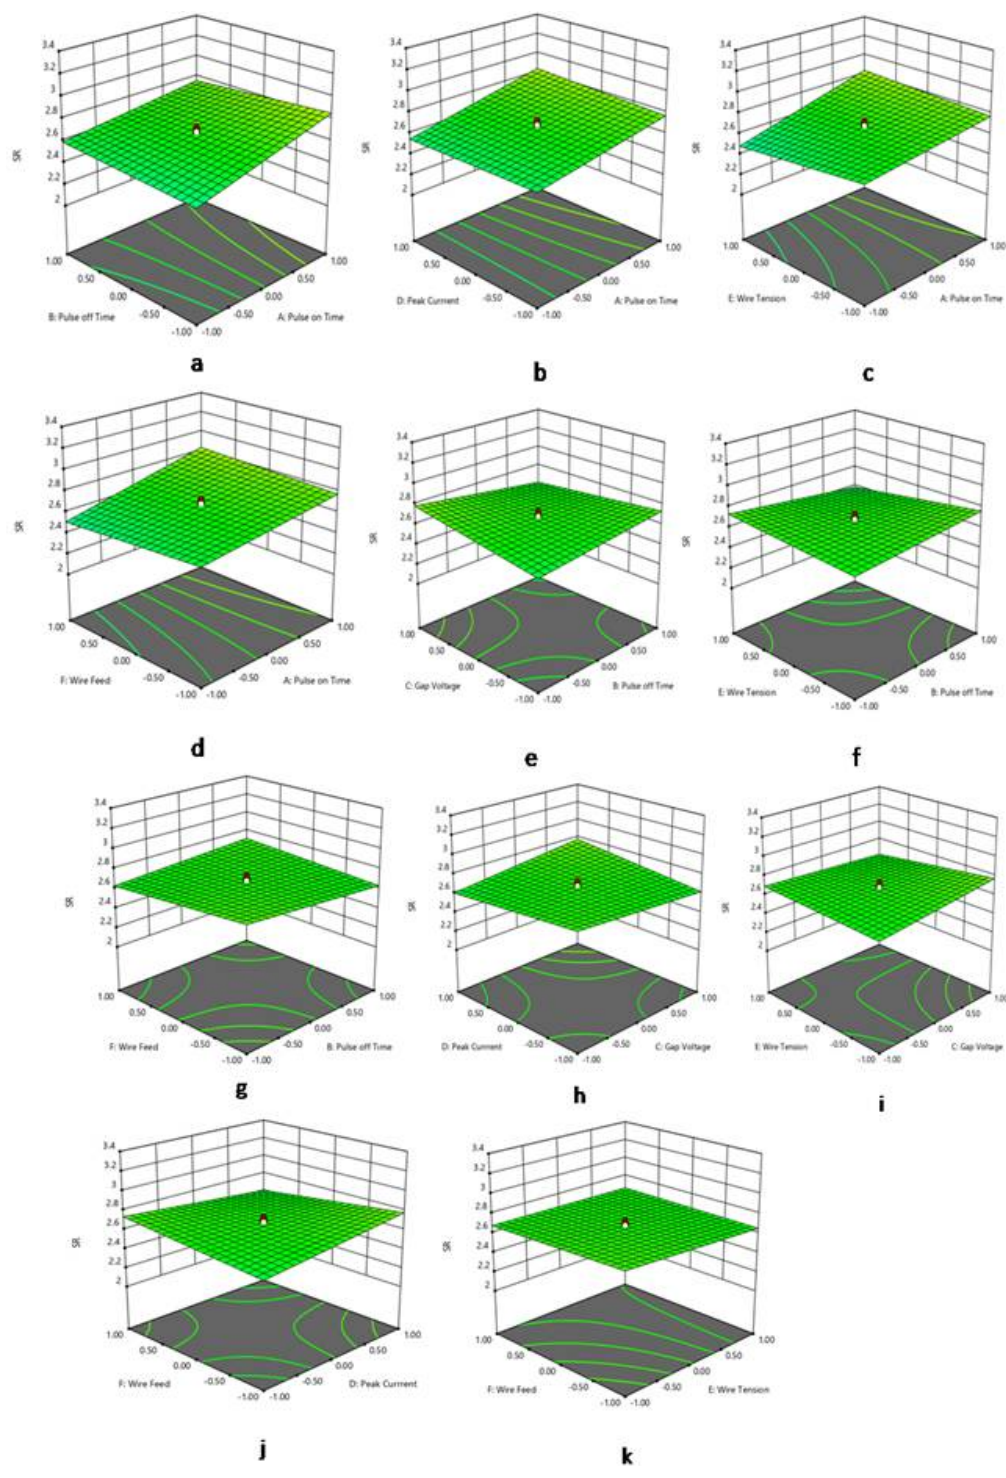
Figure 5: Three dimensional plot of combined effects of (A) pulse-on time and pulse-off time (B) pulse-on time and peak current (C) pulse-on time and wire tension (D) pulse-on time and wire feed (E) pulse-off time and gap voltage (F) pulse-off time and wire tension (G) pulse-off time and wire feed (H) gap voltage and peak current (I) gap voltage and wire tension (J) peak current and wire tension (K) peak current and wire feed (L) wire tension and wire feed on SR when other factors were kept